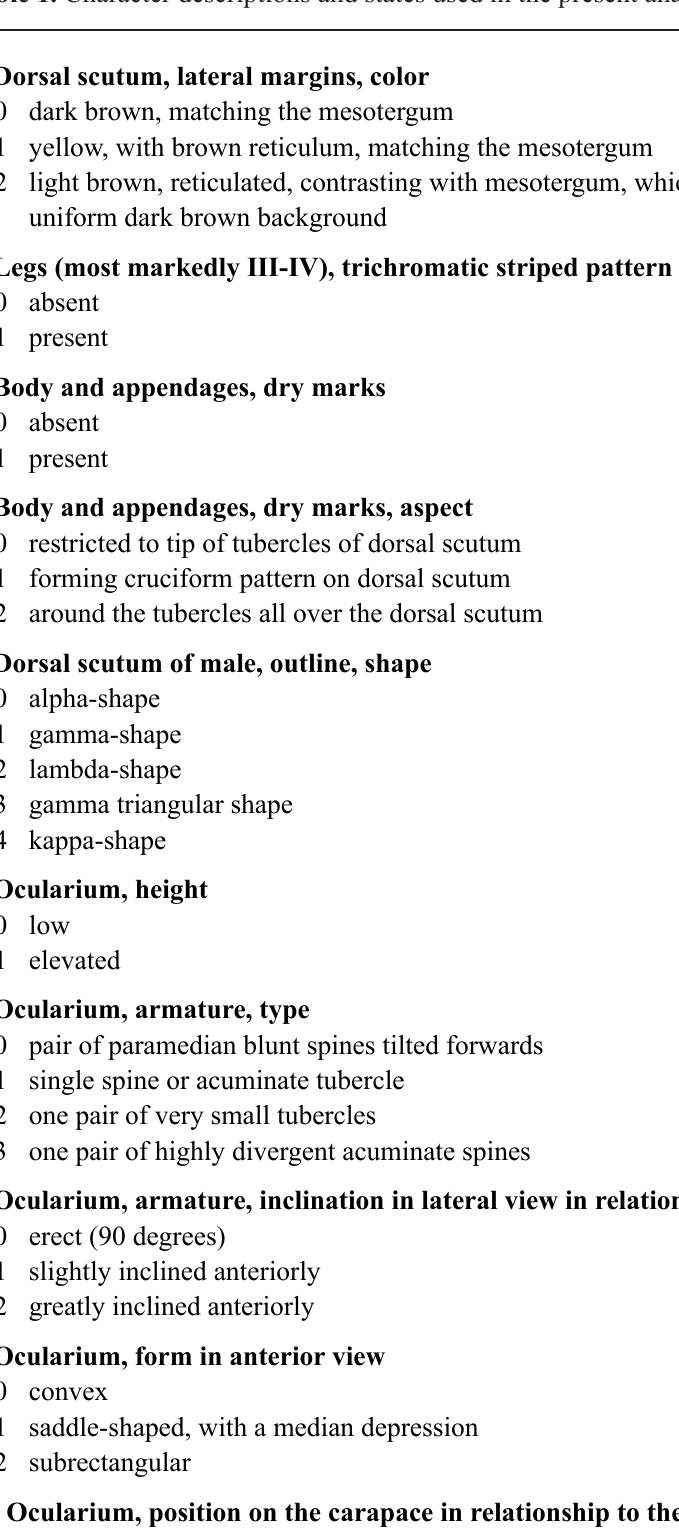
Table 1. Character descriptions and states used in the present analysis. (continued on next